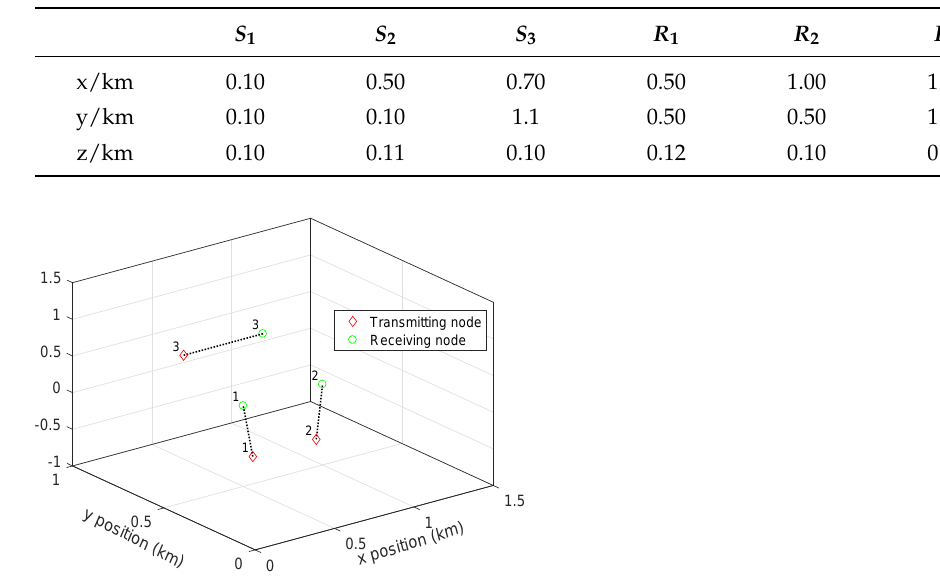
Table 1. The coordinate of transceiver nodes.